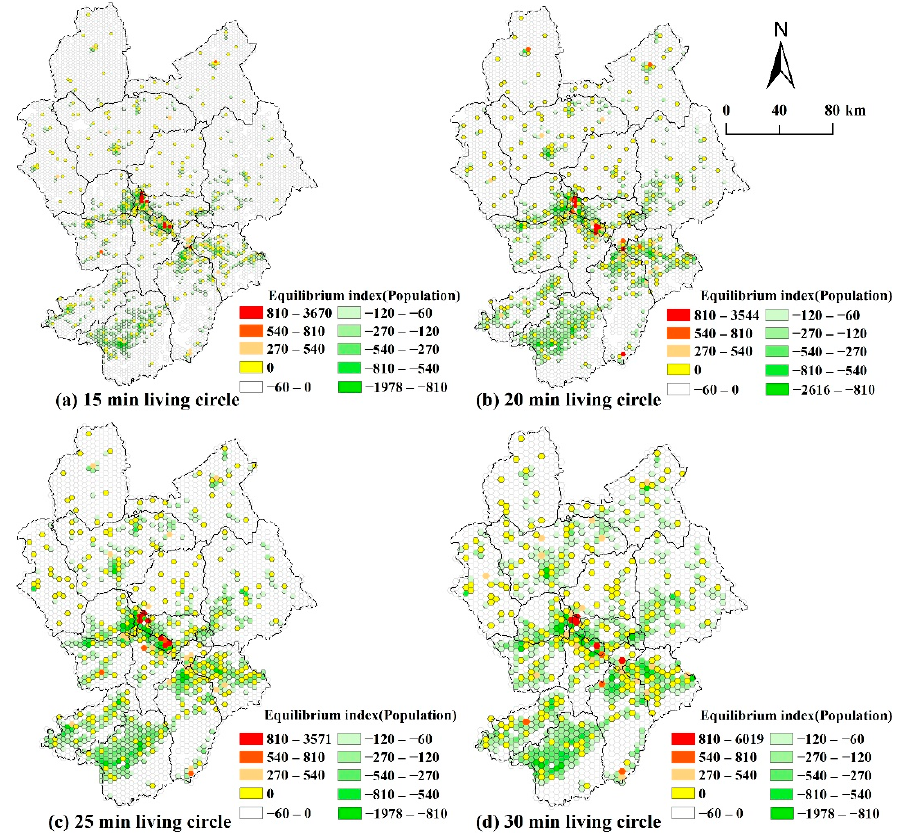
Figure 6. Spatial equilibrium distribution characteristics of primary educational services within the